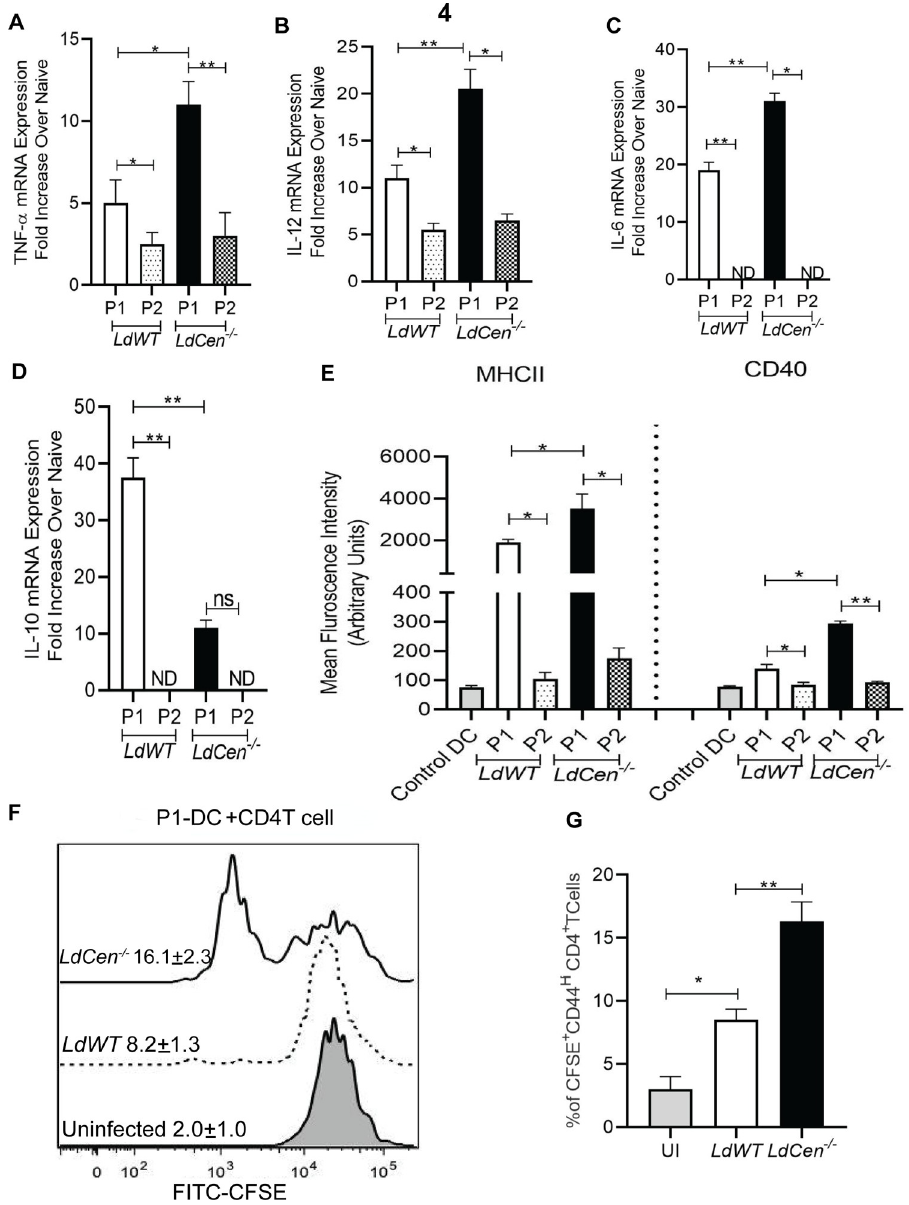
Fig 4. Higher expression of proinflammatory cytokines, co-stimulatory molecules and subsequent antigen presentation in P1 DCs that have captured LdCen -/- infected neutrophils compared to P1 DCs containing LdWT infected neutrophils. The P1 and P2 DC population from LdWT and LdCen -/- infected LYS-eGFP mice ear dLN were flow sorted as described in Fig 3 legend. Normalized expression levels of cytokines, such as (A) TNF- α ( B) IL-12 (C) IL-6 and (D) IL-10 were estimated. Data are presented as fold change from uninfected naive mice. The data represent the mean values ± standard deviations of results from 3 independent experiments that all yielded similar results (n = 6). � p < 0.05; �� p < 0.005. (E) The Mean fluorescence intensity (MFI) of the costimulatory molecules (MHCII and CD40) expression on P1 and P2 DCs from LdWT/LdCen -/- infected mice or in Cd11C + DCs from uninfected mice (control mice) ear dLN was studied and represented by the bar diagram. The data represent the mean values ± SD of results from three independent experiments that all yielded similar results (n = 6). � p < 0.05; �� p < 0.005. ( F, G ) Ag- specific CD4 T cell proliferation was estimated from P1-DC-CD4T cell coculture assay by studying CFSE dilution of gated CD4 + CD44 + T cells and is represented by the staggered offset histogram overlay and bar diagram. Cell proliferation was analyzed in triplicate experiments (n = 6), and histograms representative of mean values were overlaid for the figure.